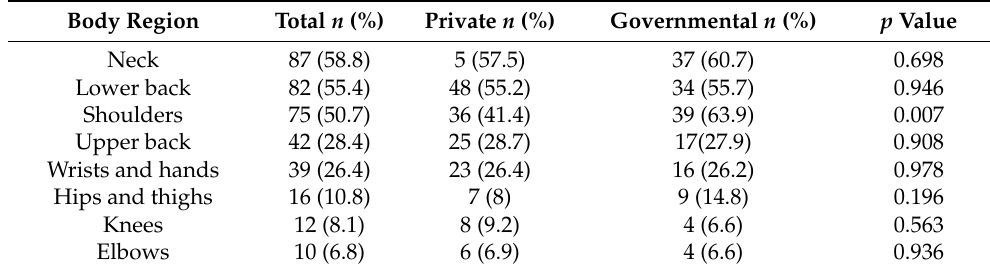
Table 2. The frequency of affected body regions by MSDs.